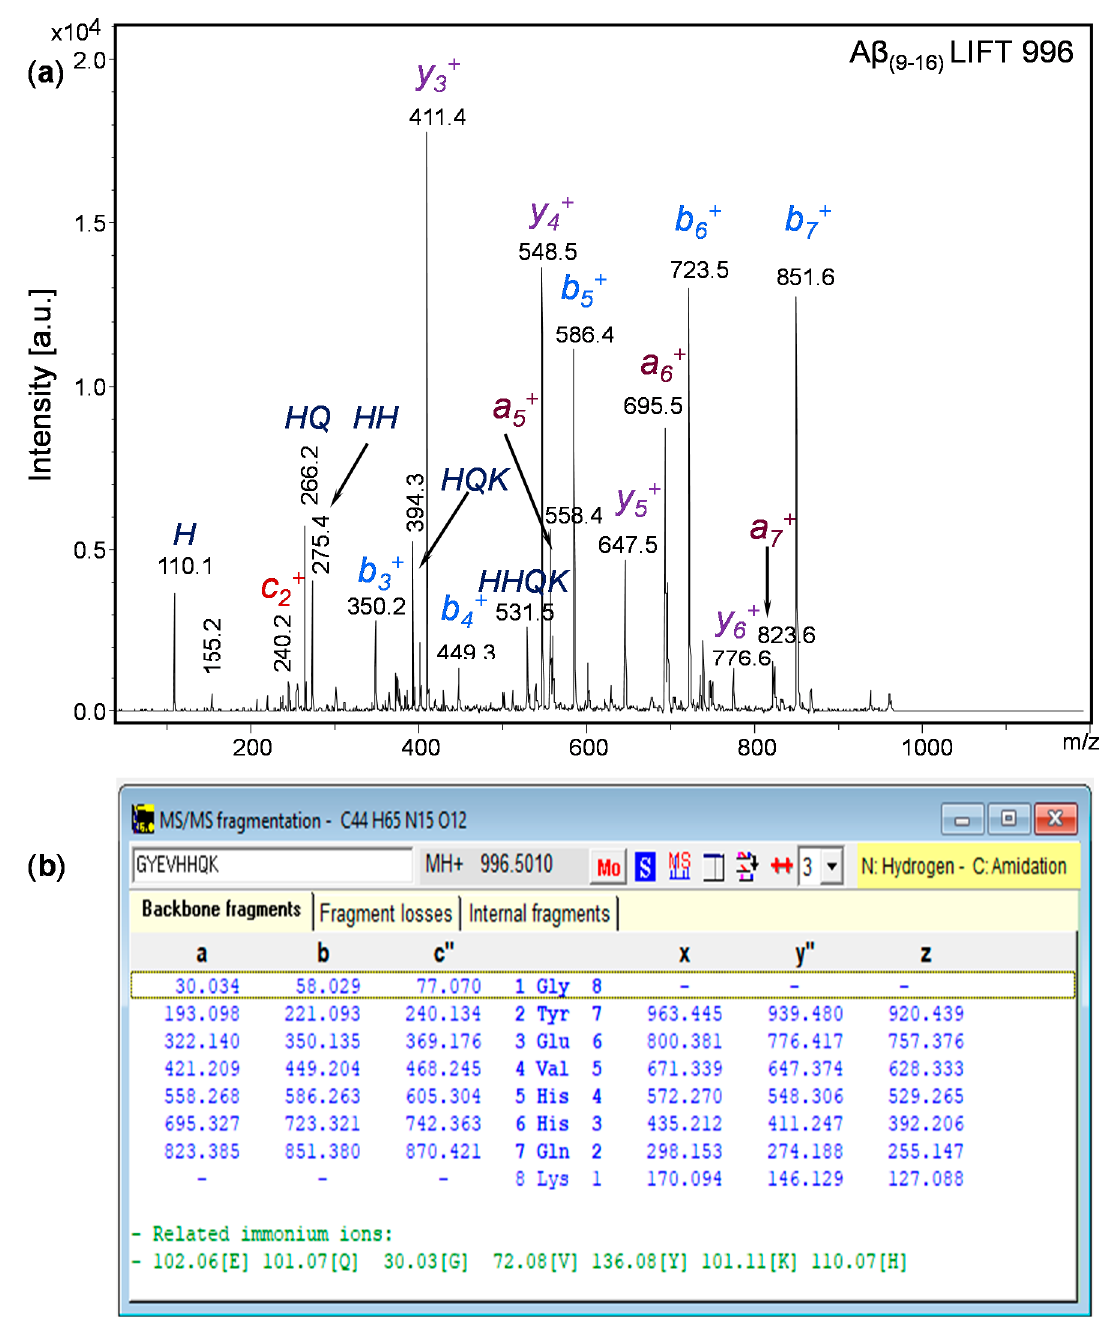
Figure 3. MS/MS fragmentation of free A β (9–16) peptide: ( a ) MS/MS spectrum of amidated A β (9–16) peptide; ( b ) theoretical calculation using GPMAW software of m / z values of the resulting fragments within the collision-induced dissociation.